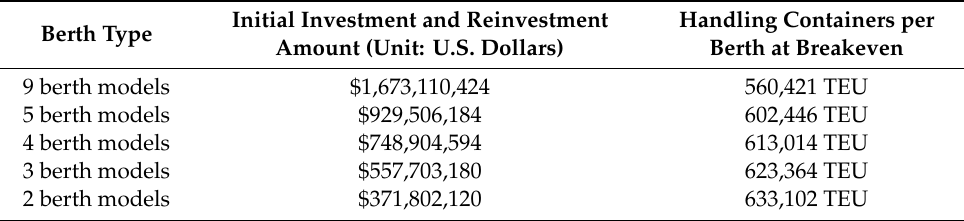
Table 12. The breakeven handling volume per